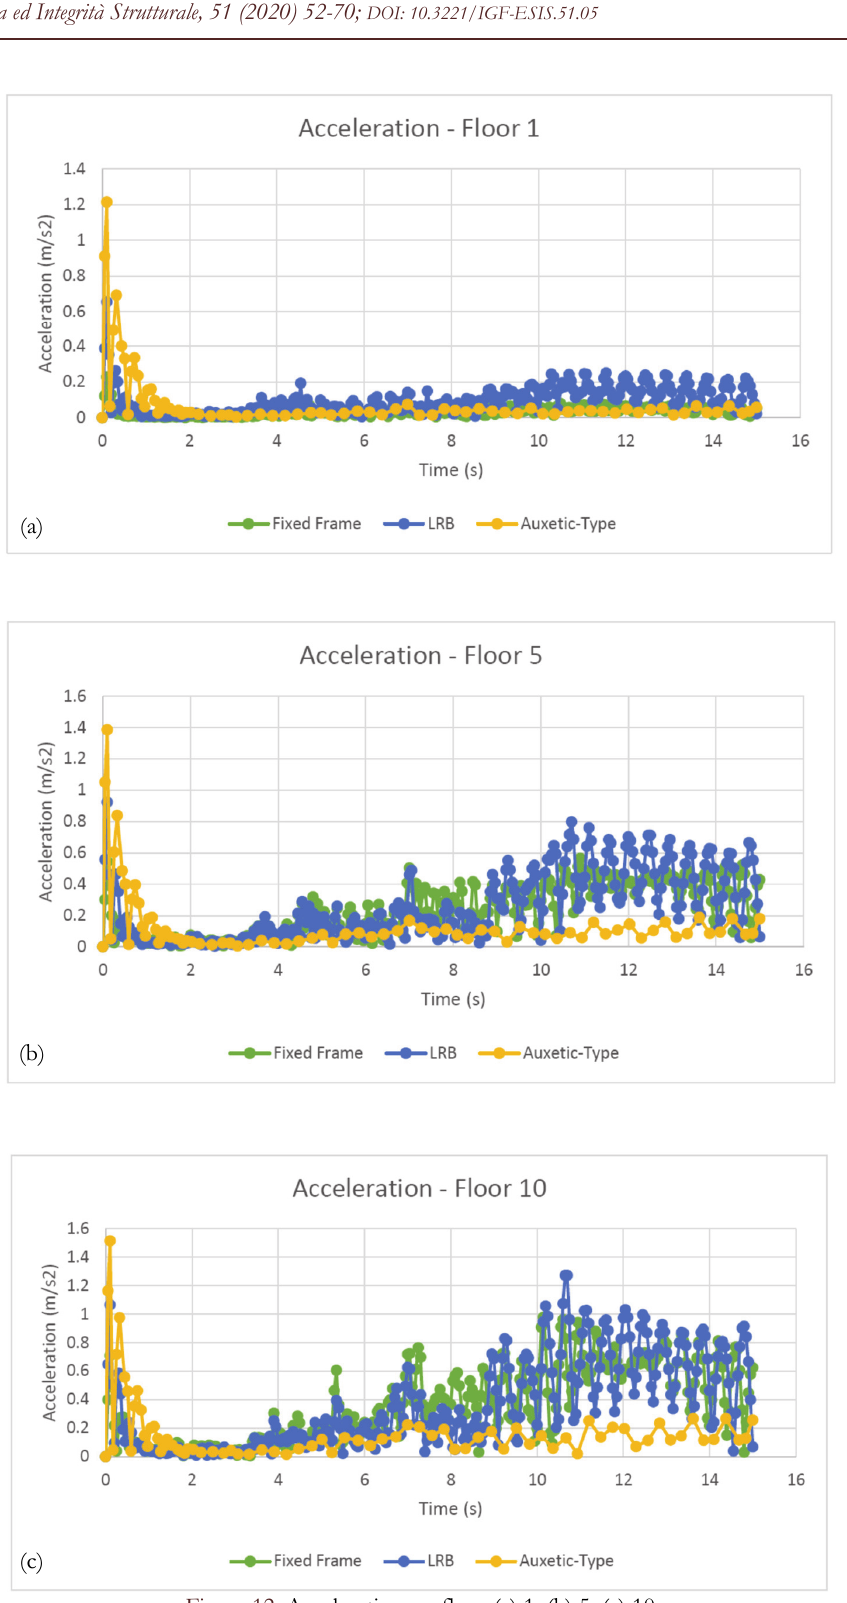
Figure 12: Acceleration on floor (a) 1, (b) 5, (c)